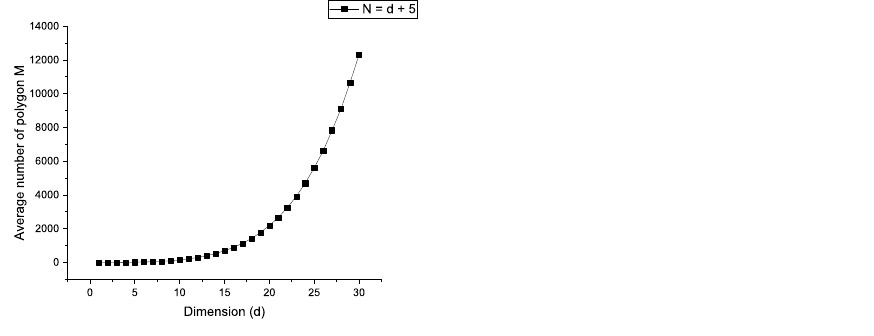
Figure 6. Relationship between the number of initial points N and the number of polygons M when the initial number of polygons is N = d + 5.